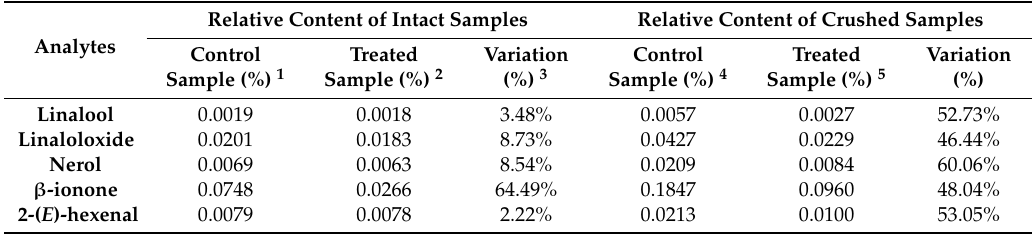
treated by SBE method.